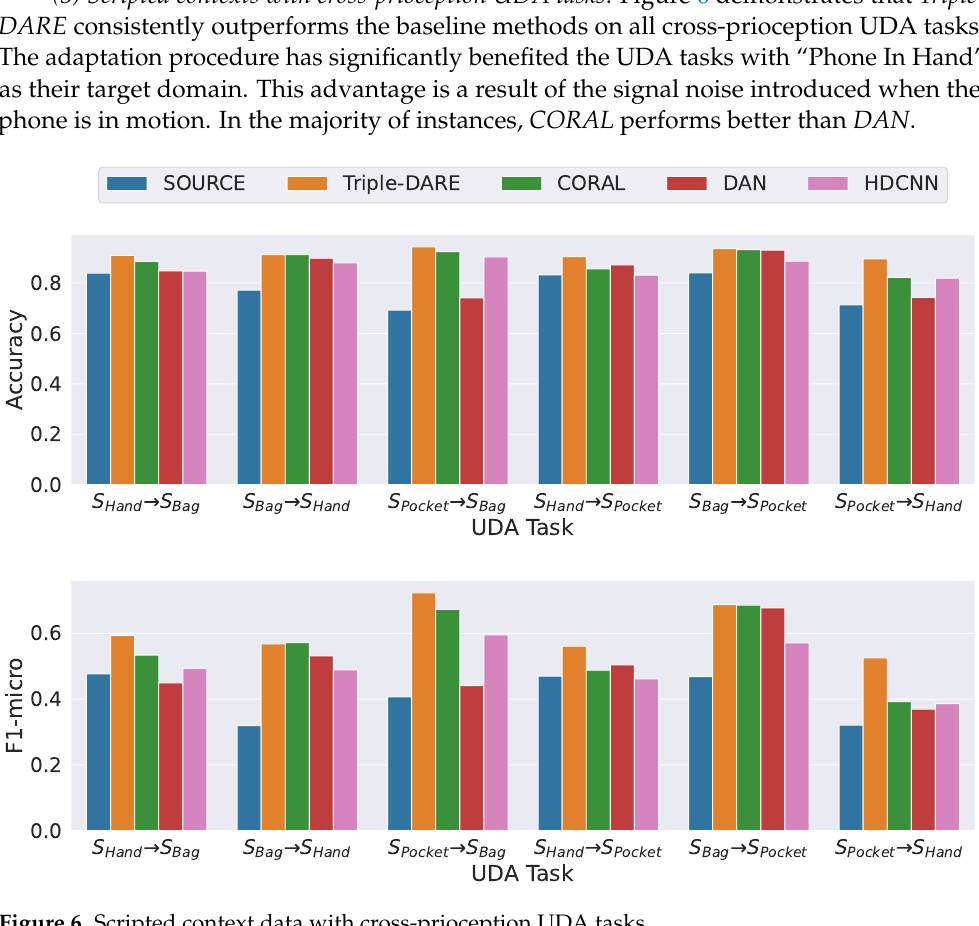
Figure 6. Scripted context data with cross-prioception UDA